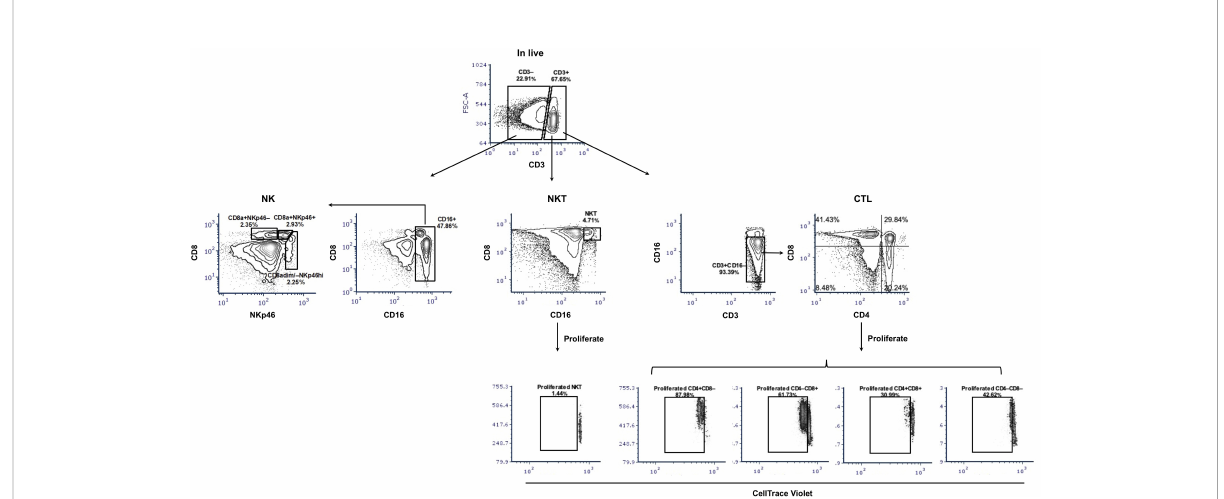
FIGURE 2 Gatinghierarchy of surface staining to identifypotential CTL, NKT, and NKcells and theirproliferation. The gating hierarchy isshown as contour plots. For phenotyping,a fi ve-color staining scheme was performed: live/dead Near-IR/CD3/CD4/CD8 a /CD16. After removal of cell debris and gatingon singlets, live cells weredivided based onthe expression ofCD3. Within CD3-positive cells, NKT cells werede fi ned as CD16 + CD8 a + and potential CTL as CD4/CD8 a subsets within CD3 + CD16 – cells. In the CD3-negative population and after gating CD16 + cells, three subsets ofNKcells wereshown: CD8a + NKp46 – , CD8a + NKp46 + , andCD8a dim/ – NKp46 hi . For proliferationassays, CellTraceViolet-labeled PBMCwerestimulated with PRRSV-1JA2 (MOI0.1) for 3 days, then collected andstainedfor live/dead Near-IR/CD3/CD4/CD8 a /CD16. The proliferatedCTL and NKT werede fi ned as CellTrace Violet dim within each subset. Stimulation with medium only orPHA was used as negative and positive controls,